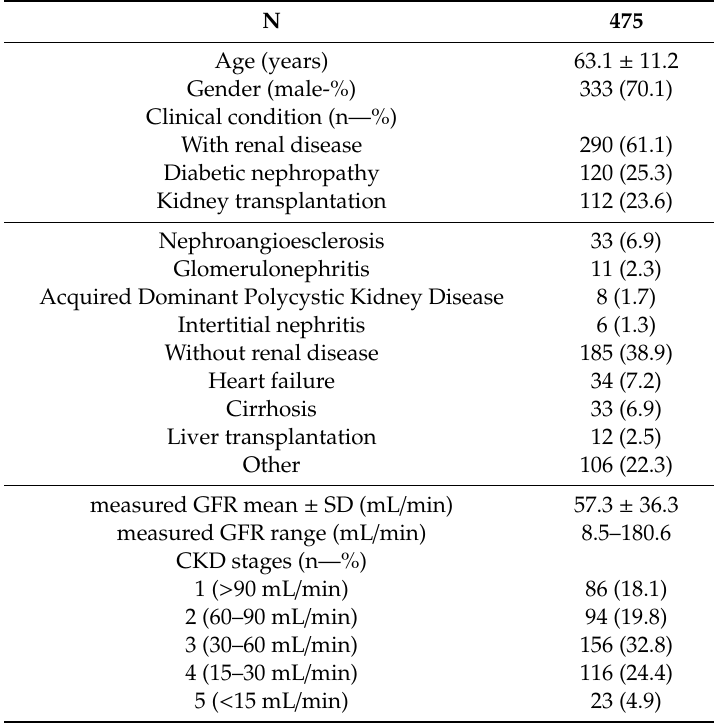
Table 1. Clinical characteristics of the patients included in the